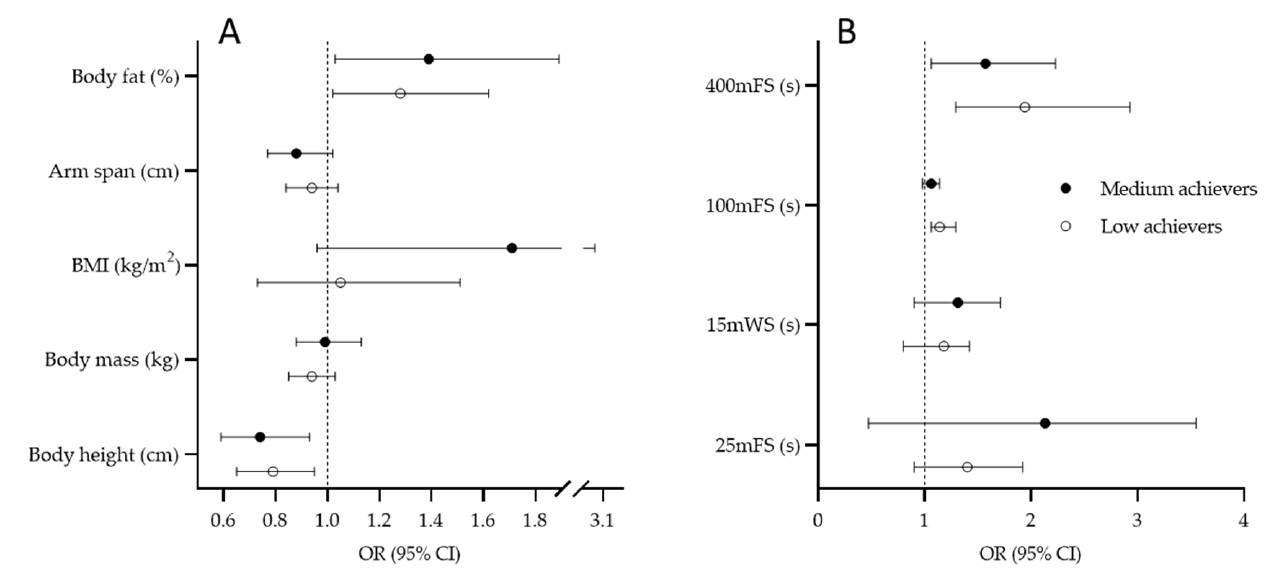
Figure 4. Results of the multinomial logistic regression for criterion “success at senior level” with high-achievement group as reference value for anthropometric predictors ( A ) and swimming predictors; ( B ) perimeter players (BMI, body mass index; 25 mFS, 25-meter freestyle swimming; 15 mWS, 15 m water polo swimming; 100 mFS, 100 m freestyle swimming; 400 mFS, 400 m freestyle swimming).